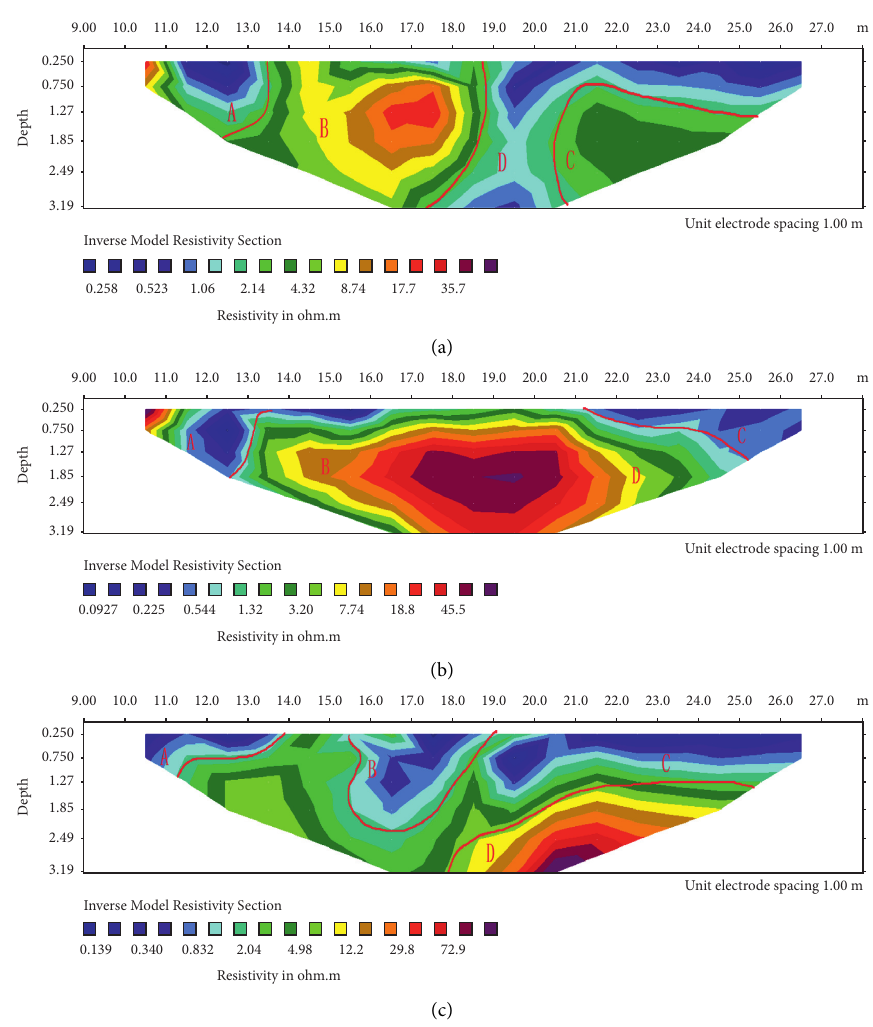
Figure 20: Soft soil reinforcement experiment: (a) electrical structure information of undisturbed stratum, (b) electrical structure in- formation when half of the mortar is filled, and (c) formation electrical structure information after